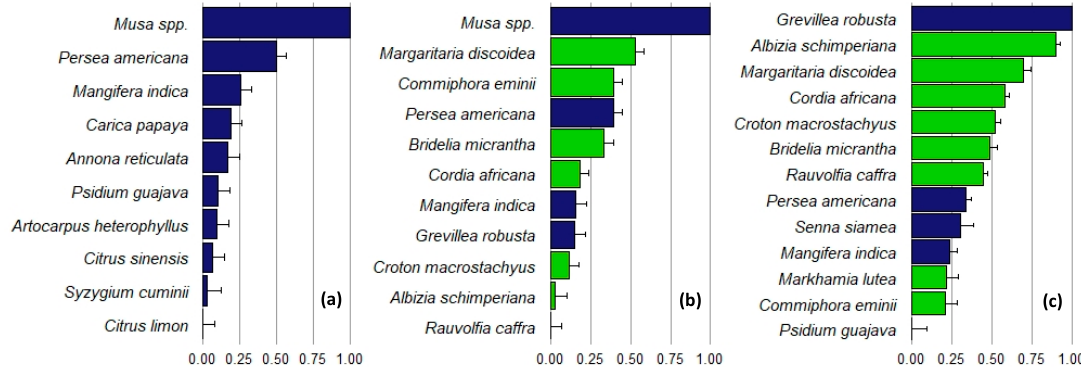
Figure 4. Scores and quasi-standard errors of tree species for ( a ) food provision, ( b ) fodder supply and ( c ) firewood supply. Dark blue bars represent exotic, and green bars indigenous tree species.